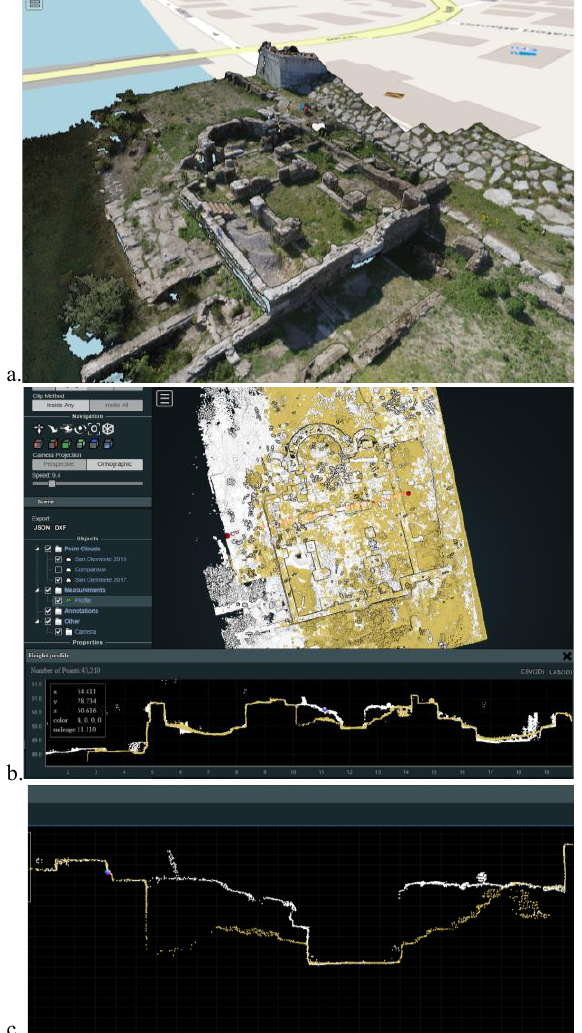
Figure 6. Web visualization of the San Clemente site: (a) survey carried out in 2015; (b) comparison of the point clouds acquired in 2015(white) and 2017 (sand); (c) detail of the cross-section